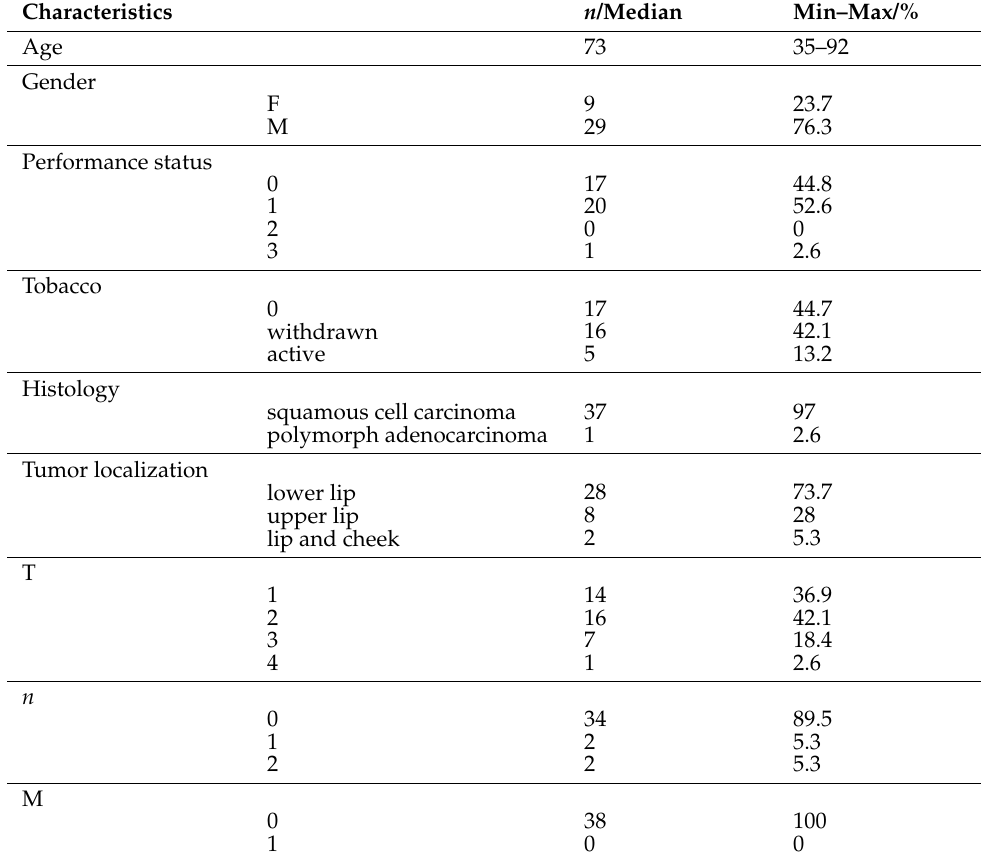
Table 1. Patient characteristics ( n =